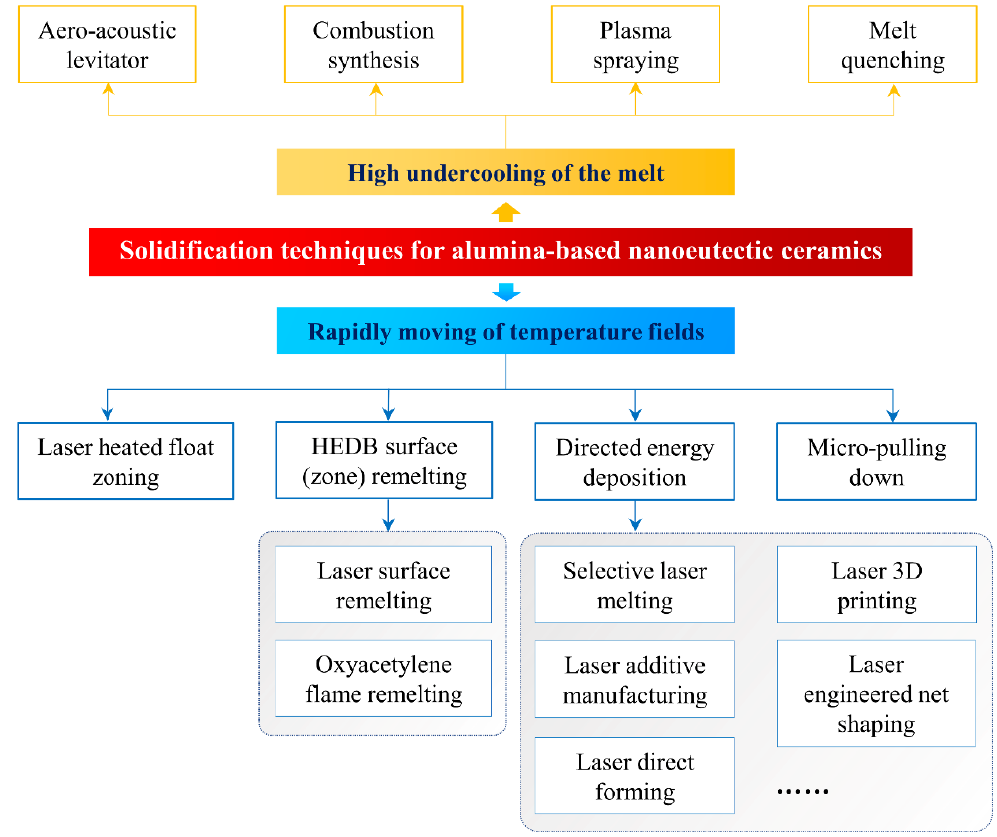
Figure 2. Classification of processing methods of alumina-based nanoeutectic ceramics.